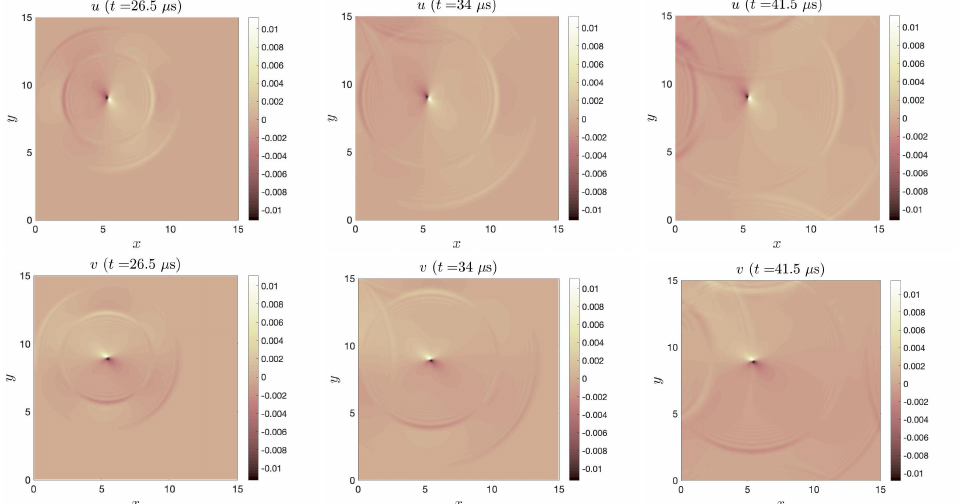
Figure 3. Components of the displacement vector u ( top ) and v ( bottom ) at times t = 26.5, 34, and 41.5 µs.